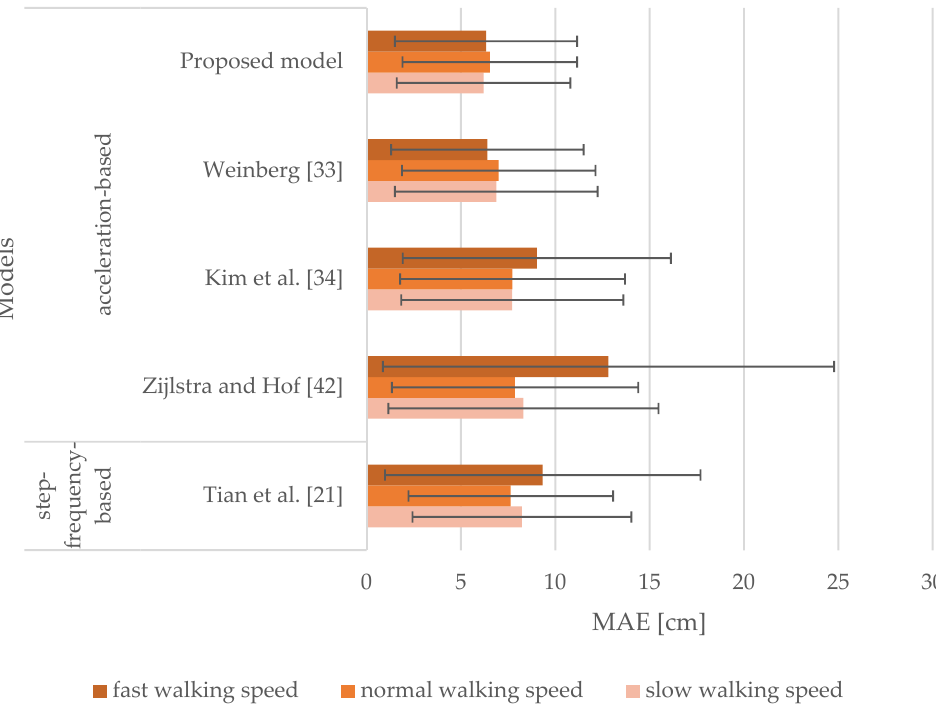
Figure 6. MAEs and SDs of the models for the smartphone attached to the upper arm for slow, normal, and fast walking speeds.